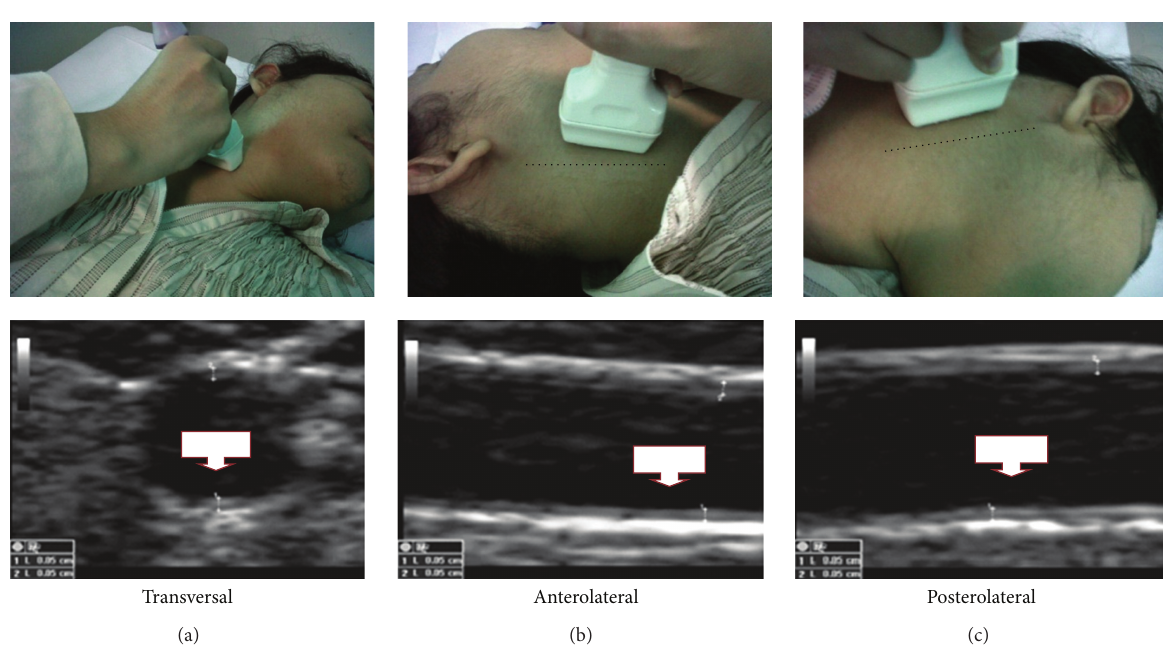
Figure 1: Observation angles for CIMT measurement: (a) transversal, (b) anterolateral, and (c) posterolateral. The dashed lines represent the sternocleidomastoid